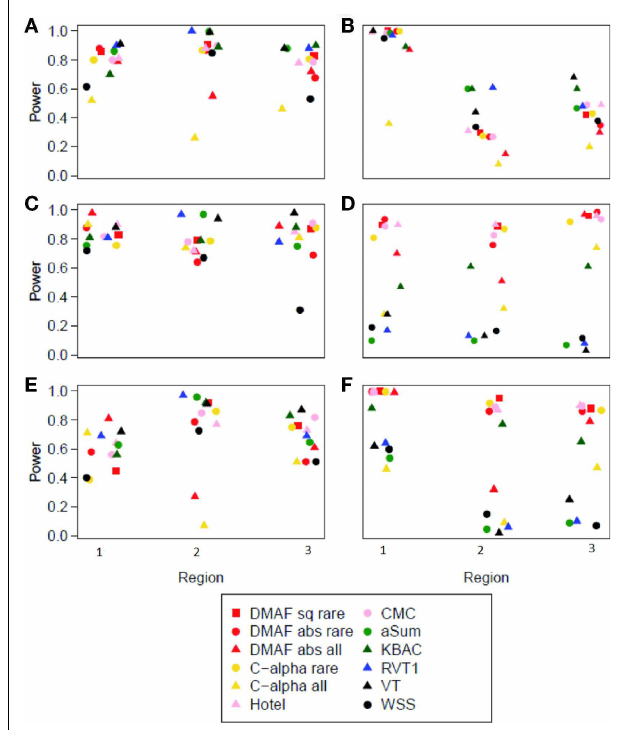
FIGURE 1 | Power at empirical type I error = 0.05 for each method and region. (A–F) show results from corresponding models (A–F)